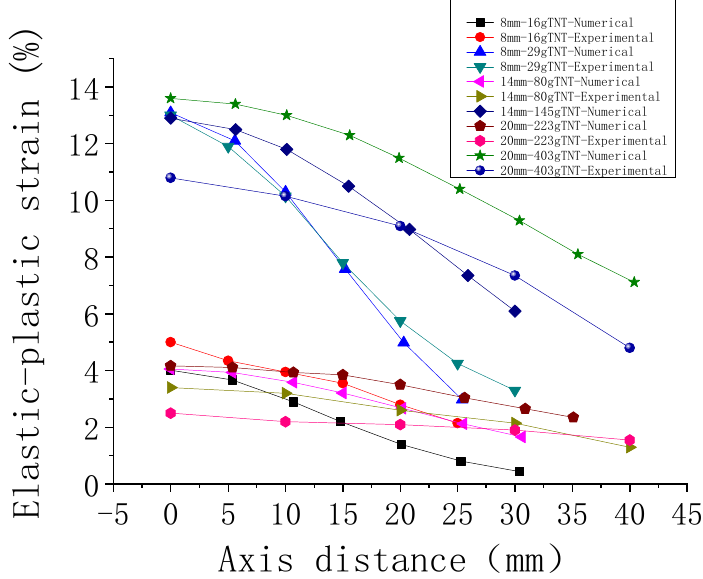
Figure 9. Comparison between experimental and numerical results.